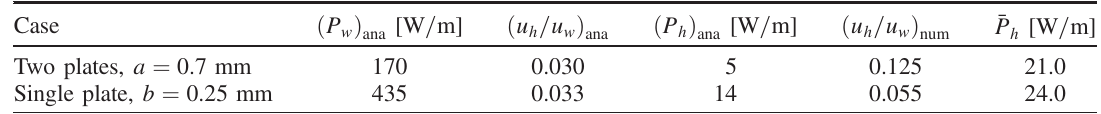
Þ =u ; Joule h w ana Þ =u ; and h w num